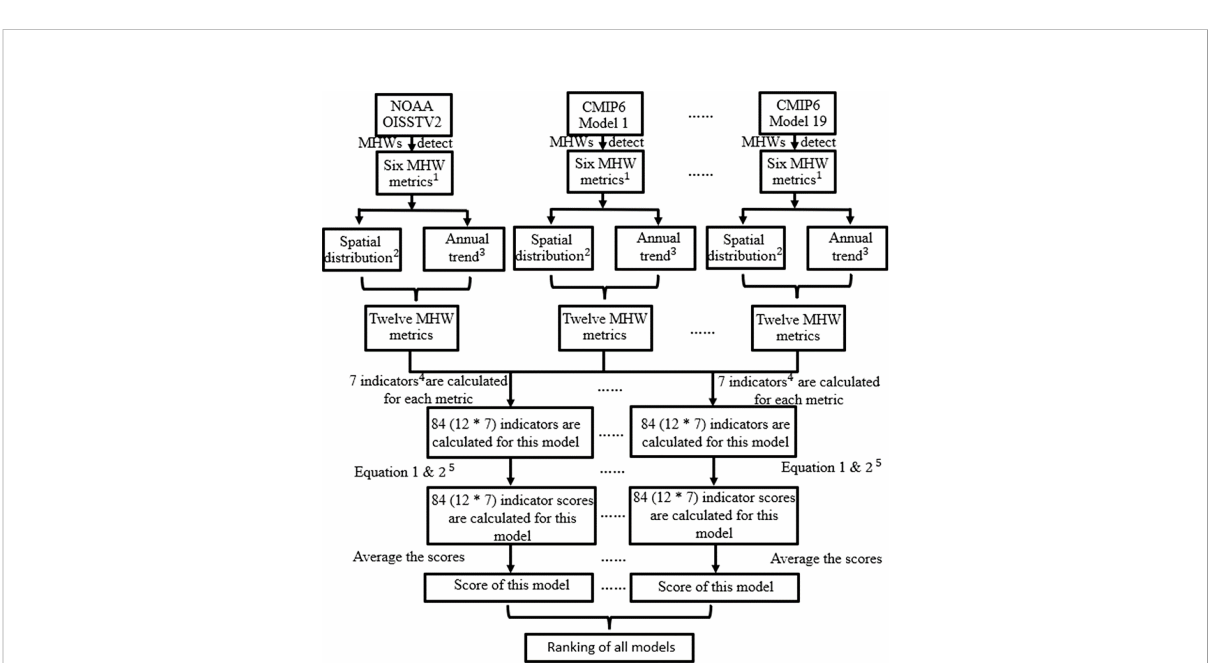
FIGURE 2 Flowchart summarizing the evaluation methods used in this study. 1 Six MHW metrics: Number, Duration, Days, CumInt, MaxInt and MeanInt. 2 Spatial distribution: spatial distribution of multi-year average. 3 Annual trend: spatially weighted average of annual average. 4 Seven indicators: Root Mean Square Error, Mean Absolute Percentage Error, Correct-Recognition Rate, Under-Recognition Rate, Over-Recognition Rate, Regression Coef fi cient and Taylor Scores. 5 Equation 1 & 2: Equation 1 for Taylor Scores and Correct-Recognition Rate, Equation 2 for the other (cid:1) 40 + 60, Equation 2: Grade = x max − x i (cid:1) 40 + 60. fi ve indicators. Equation 1: Grade = x i − x min x max − x min x max − x min